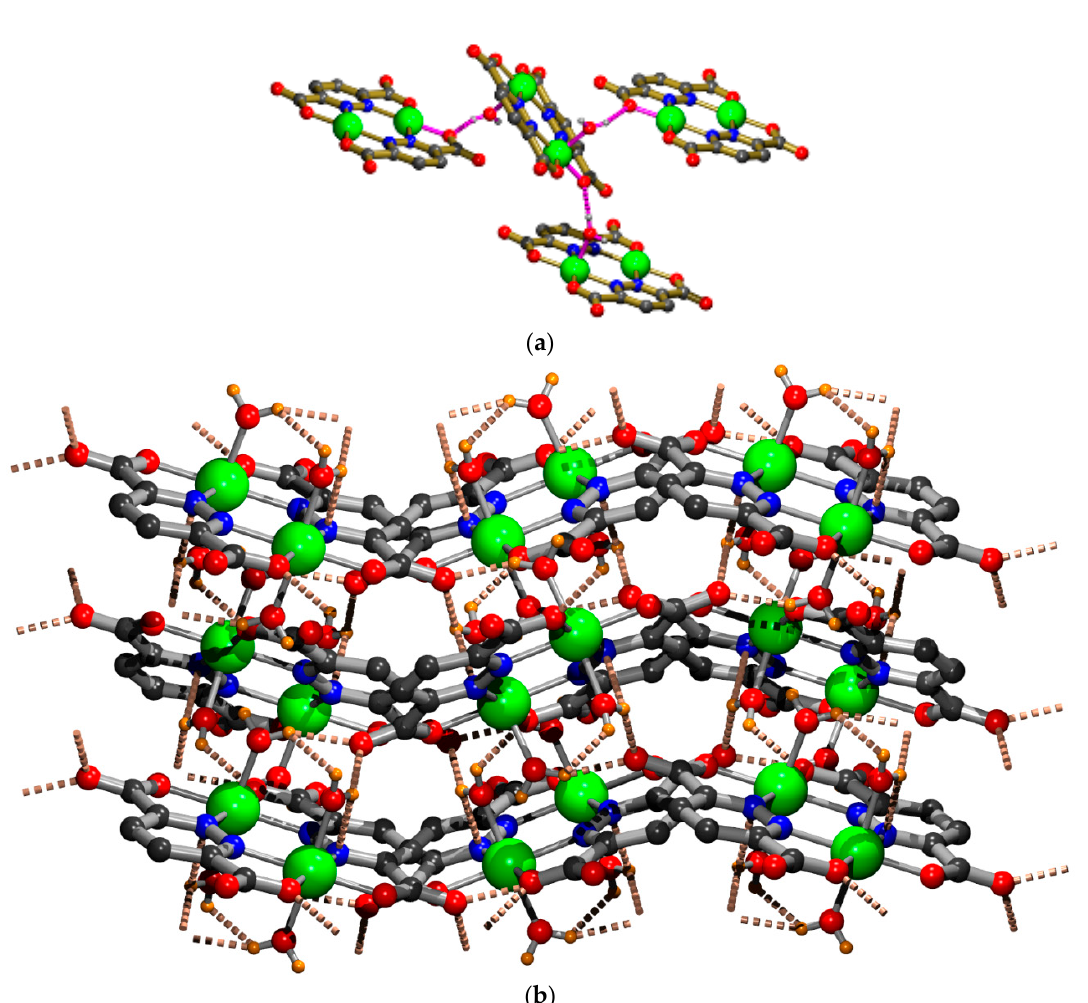
Figure 3. ( a ) The coordination environment of the Fe (II) ions in complex 1 showing intramolecular hydrogen bonding interactions. (Strong O-H···O hydrogen bonding interaction). (Blue=Nitrogen, Red=Oxygen, Green=Iron, Yellow= Hydrogen). ( b ) 3D supramolecular structure formed by hydrogen bonding interactions (Strong O-H···O hydrogen bonding interaction). (Blue=Nitrogen, Red=Oxygen, Green=Iron, Yellow= Hydrogen).